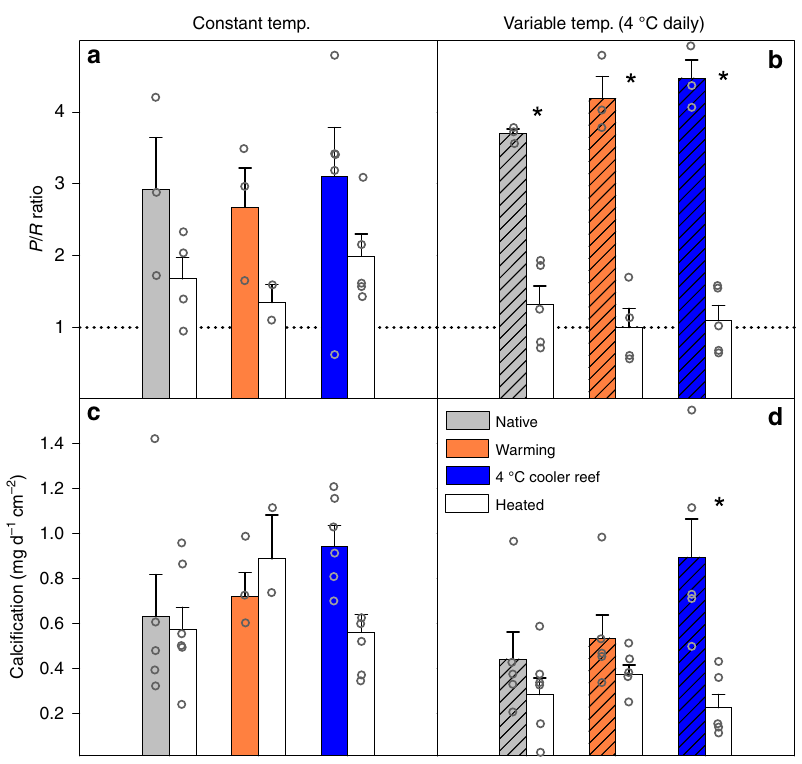
Fig. 6 Photosynthesis-to-respiration ( P / R ) ratios and calci fi cation rate at the end of the heat stress test. Acropora aspera corals were maintained under a , c constant daily temperatures or b , d 4 °C daily temperature variability. The heat stress test followed long-term exposure to three different temperature regimes. Mean ± 1 S.E.M. is shown. Grey circles indicate individual data points. Asterisks indicate a signi fi cant difference between ambient and heat- stressed corals at each temperature and variability regime ( p < 0.05; Tukey post hoc tests). The dotted line in a , b represents the transition from